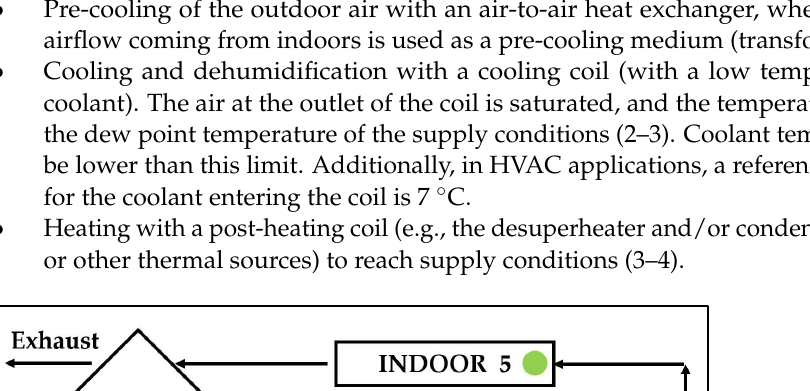
Figure 2. Schematic representation of a HVAC system with traditional dehumidification.